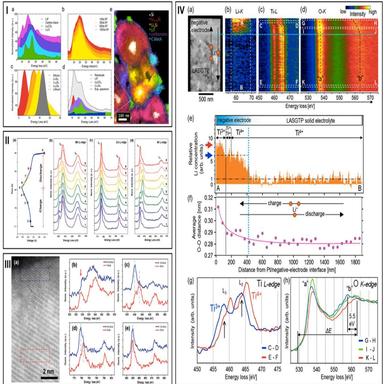
.2. EELS analyses at surfaces and interfaces in Li-battery materials. I) (a) Plasmon spectra (references): LiF, C black, Li2CO3, and Li2O. (b) Effect of electron doses on the plasmon spectra of Li2CO3. (c) Plasmon spectra (references) of LixSi alloys. (d) MLLS fitting of an experimental spectrum obtained after integration over four pixels in (e). (e) MLLS fitting of a spectrum image acquired in a region of an electrode charged to 3000 mAh.g − 1 , containing multiple phases: LiF (green), Li2CO3 (purple), car